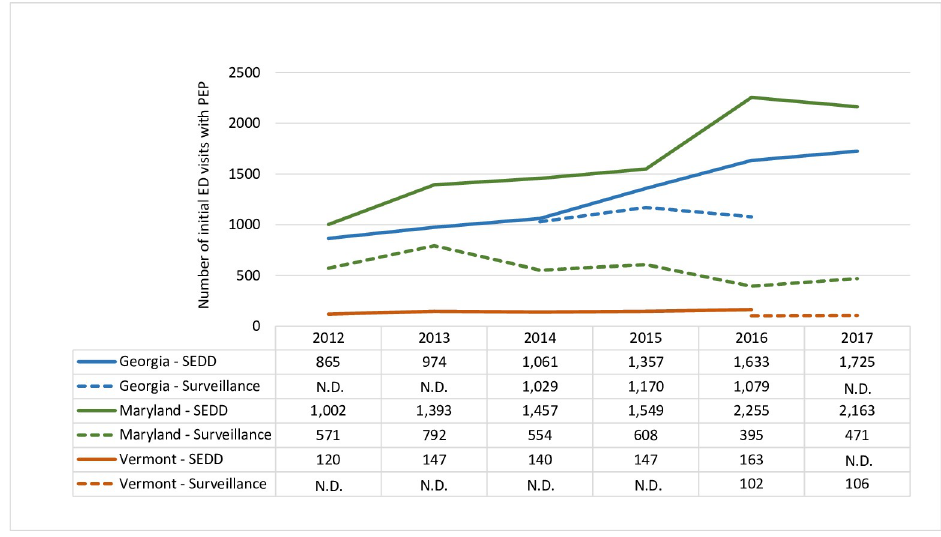
Fig 3. Comparison of PEP estimates from state-level surveillance and emergency department visits for three states. The number of people who received PEP reported by state-level surveillance compared to the number of initial emergency department visits based on the State Emergency Department Data (SEDD) for Vermont, Maryland, and Georgia–2012–2017. N.D. = No data.